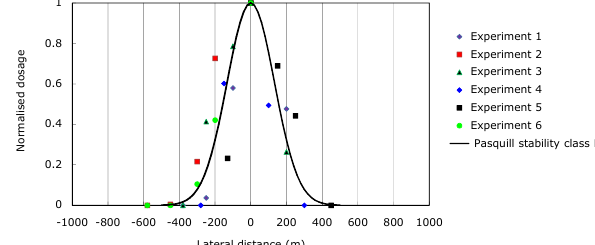
Fig. 6. Lateral concentration profiles during REPARTEE II. Results are displayed based on source X for the arc furthest away from the sources (910–980m), i.e. for receptors 1, 2, 3, 6 and 7. The origin for the lateral distance has been located at has been located at the re- ceptor measuring the highest concentration. A positive distance im- plies going southwards along the arc and a negative distance going northwards. The lateral profile is calculated from Pasquill stability class D using Briggs urban parameters at